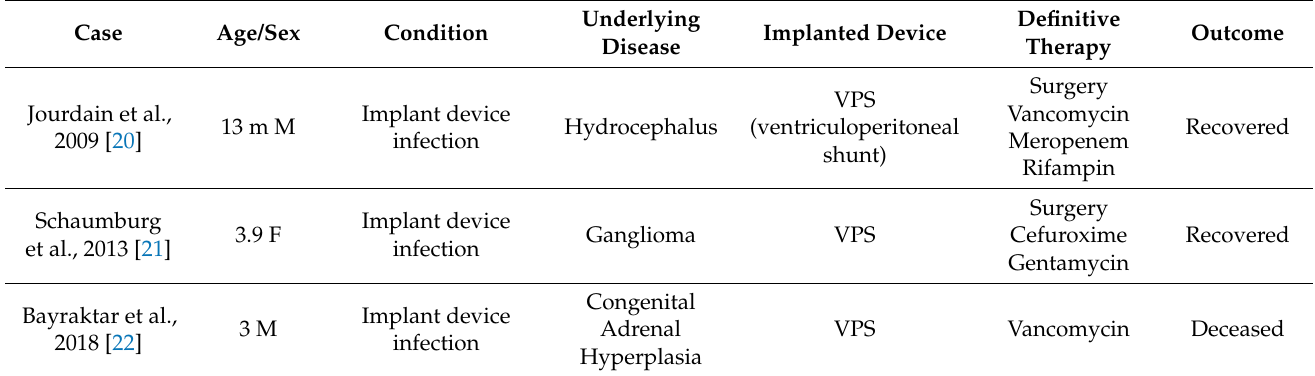
Table 5. Pediatric with implants